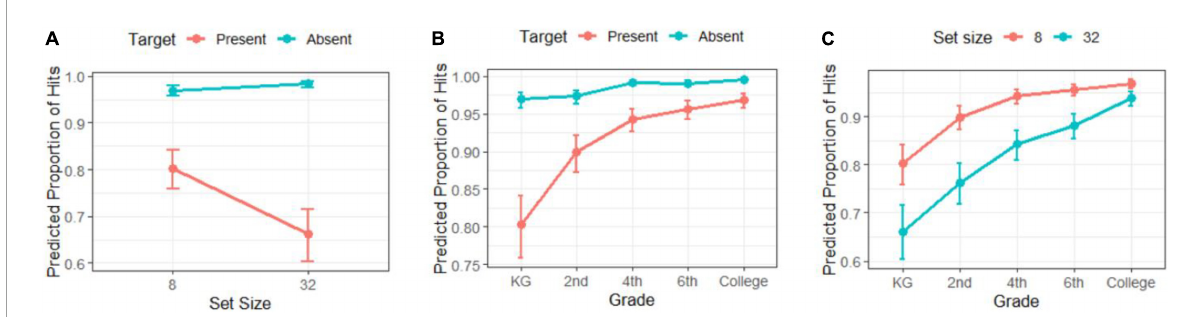
FIGURE5 Proportion of correct responses estimated with the General Linear Mixed Model in the visual search task as a function of (A) set size and target, (B) grade and target, and (C) set size and target. The bars represent CIs for each estimation (dots).